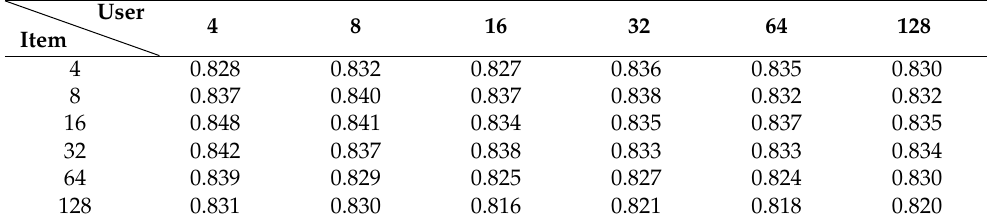
Table 4. The effect of size of triple set on AUC in Last.FM.